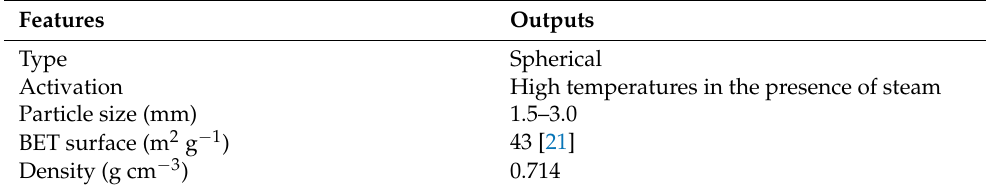
Table 2. Properties of ZnO